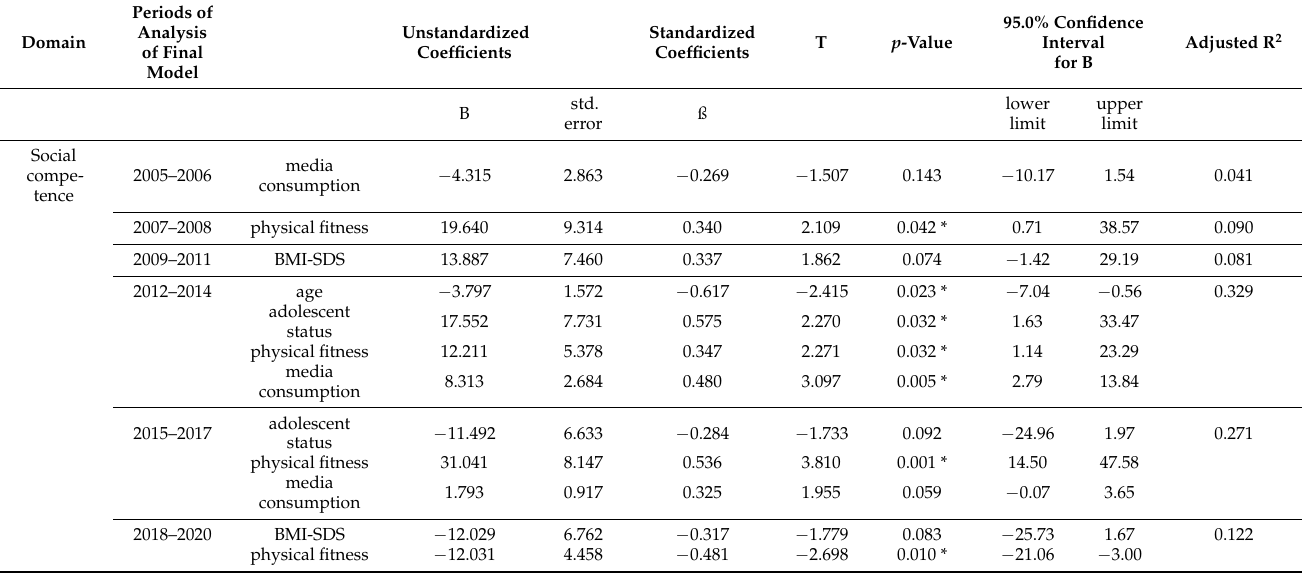
Table 6. Linear regression analysis (backward) of the social competence